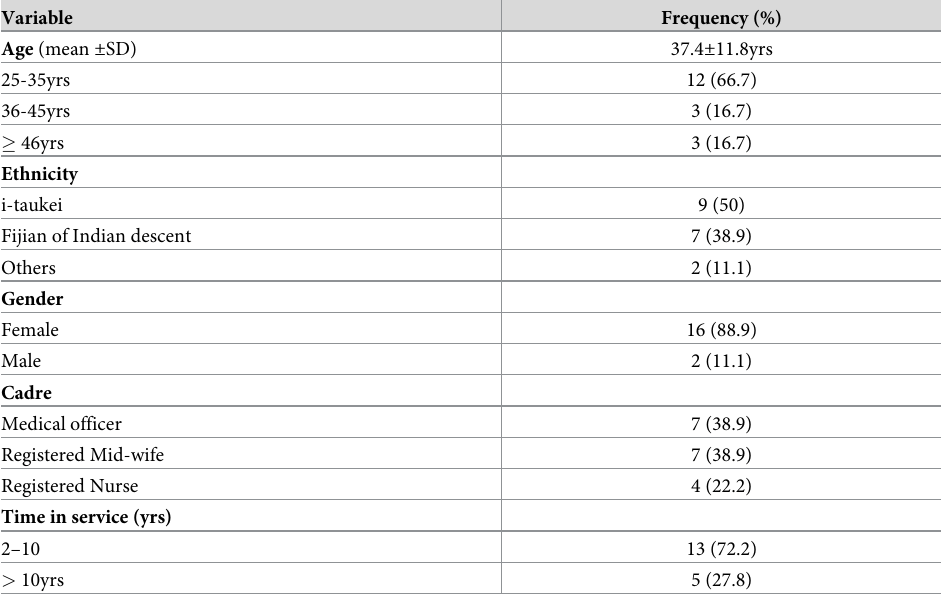
Table 1. Characteristic of the